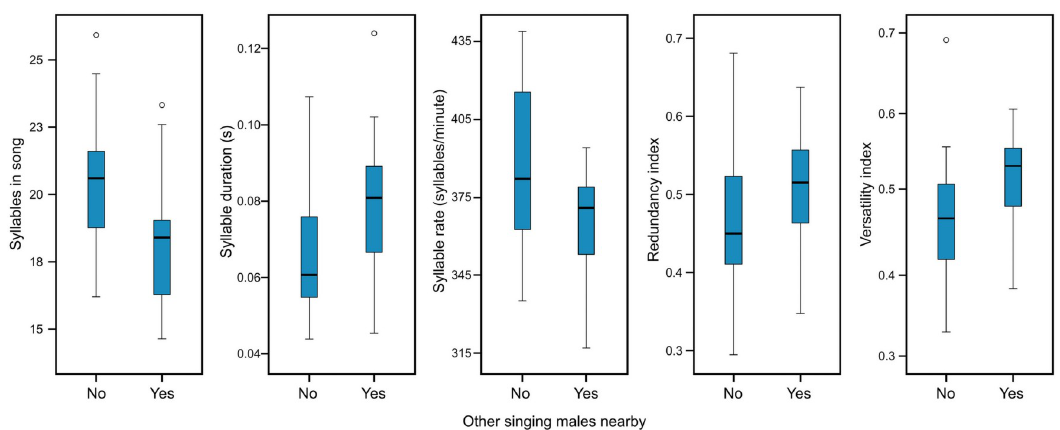
Fig 5. Box-and-whisker plots describing variation in Willow Warblers’ song characteristics in relation to the presence of other singing males nearby. Boxes indicate median and first and third quartiles. Whiskers represent the minimal and maximal values within 1.5 times the interquartile range. Open circles are